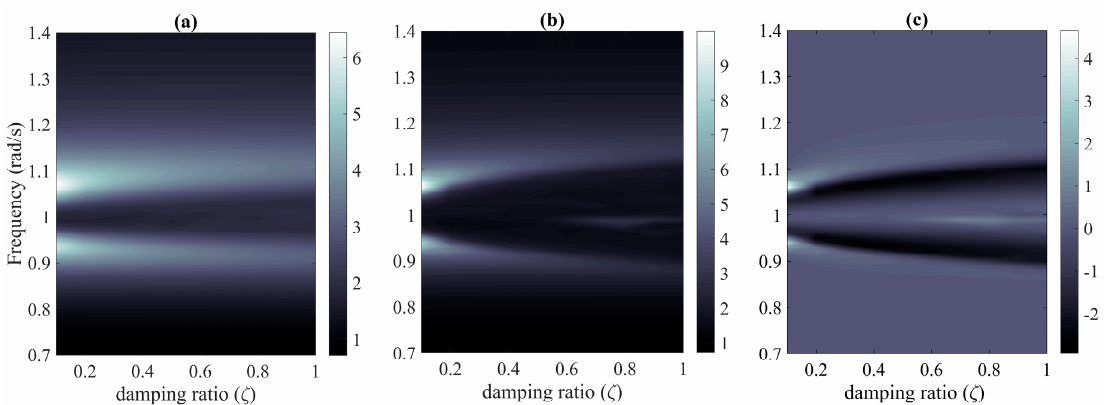
Figure 5. Acceleration response of ( a ) STMD; and ( b ) SHMD; and their ( c ) difference at different damping ratios. (Units of acceleration response in m 2 /s 3 /rad).